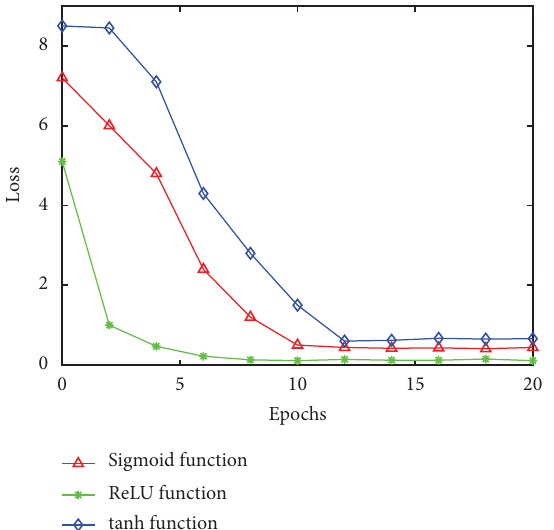
Figure 5: Comparison of training efects before and after adding L1